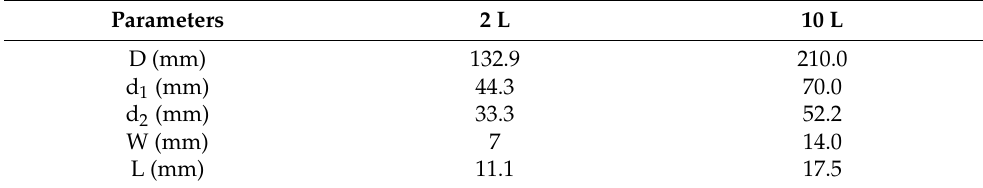
Table 2. Stirrer parameters for the 2 L and 10 L reactors.